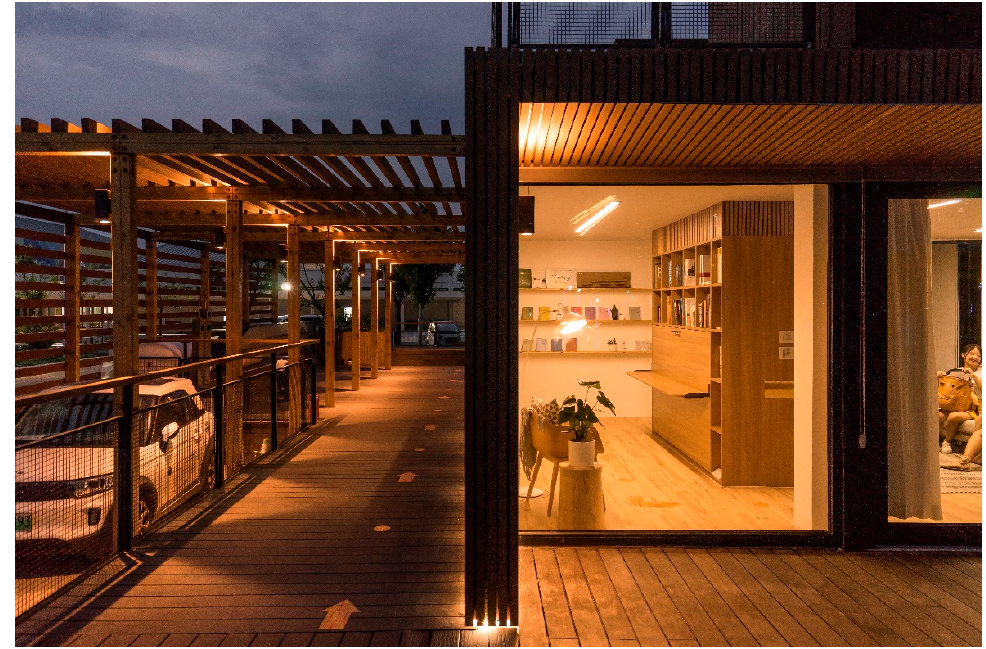
Figure 7. Landscape gallery frame on the west side of the building (actual photo) .